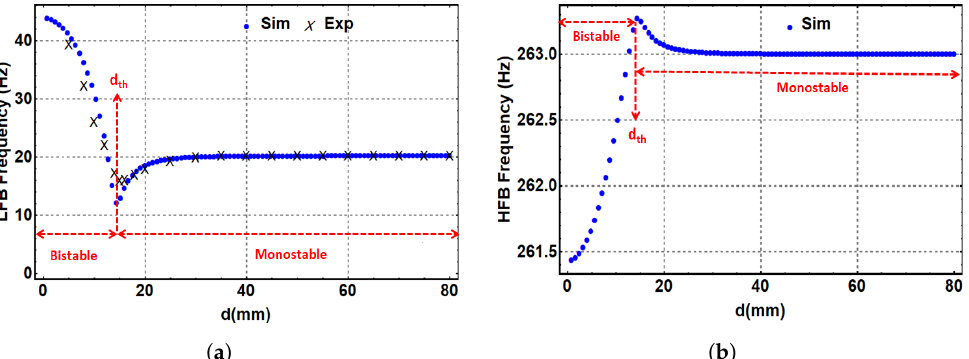
Figure 5. ( a ) The simulated and experimental variations in the LFB’s natural frequency with the separation distance. ( b ) The simulated variation in the HFB’s natural frequency with the separa- tion